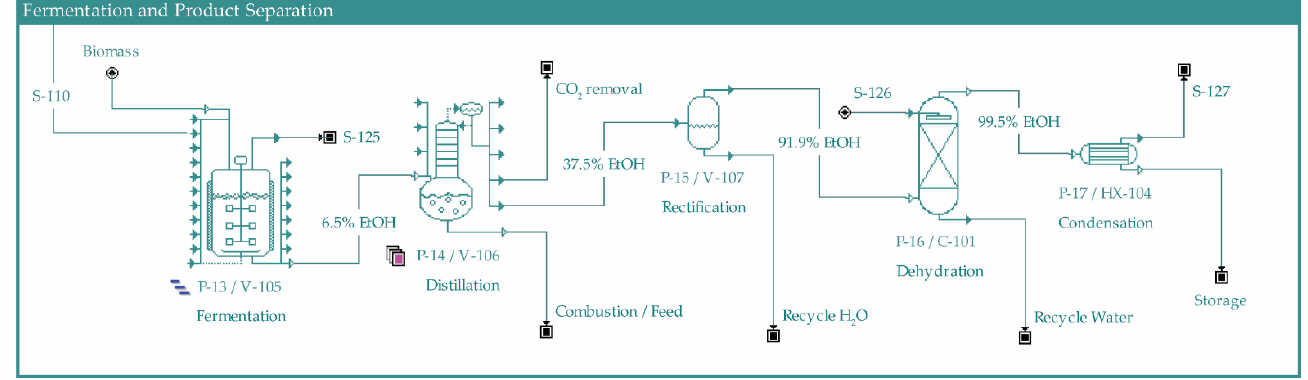
Figure 3. Process flow diagram of the bioethanol production process from spent sugar beet pulp, consisting of fermentation and product separation (distillation, rectification, and dehydration) stages.